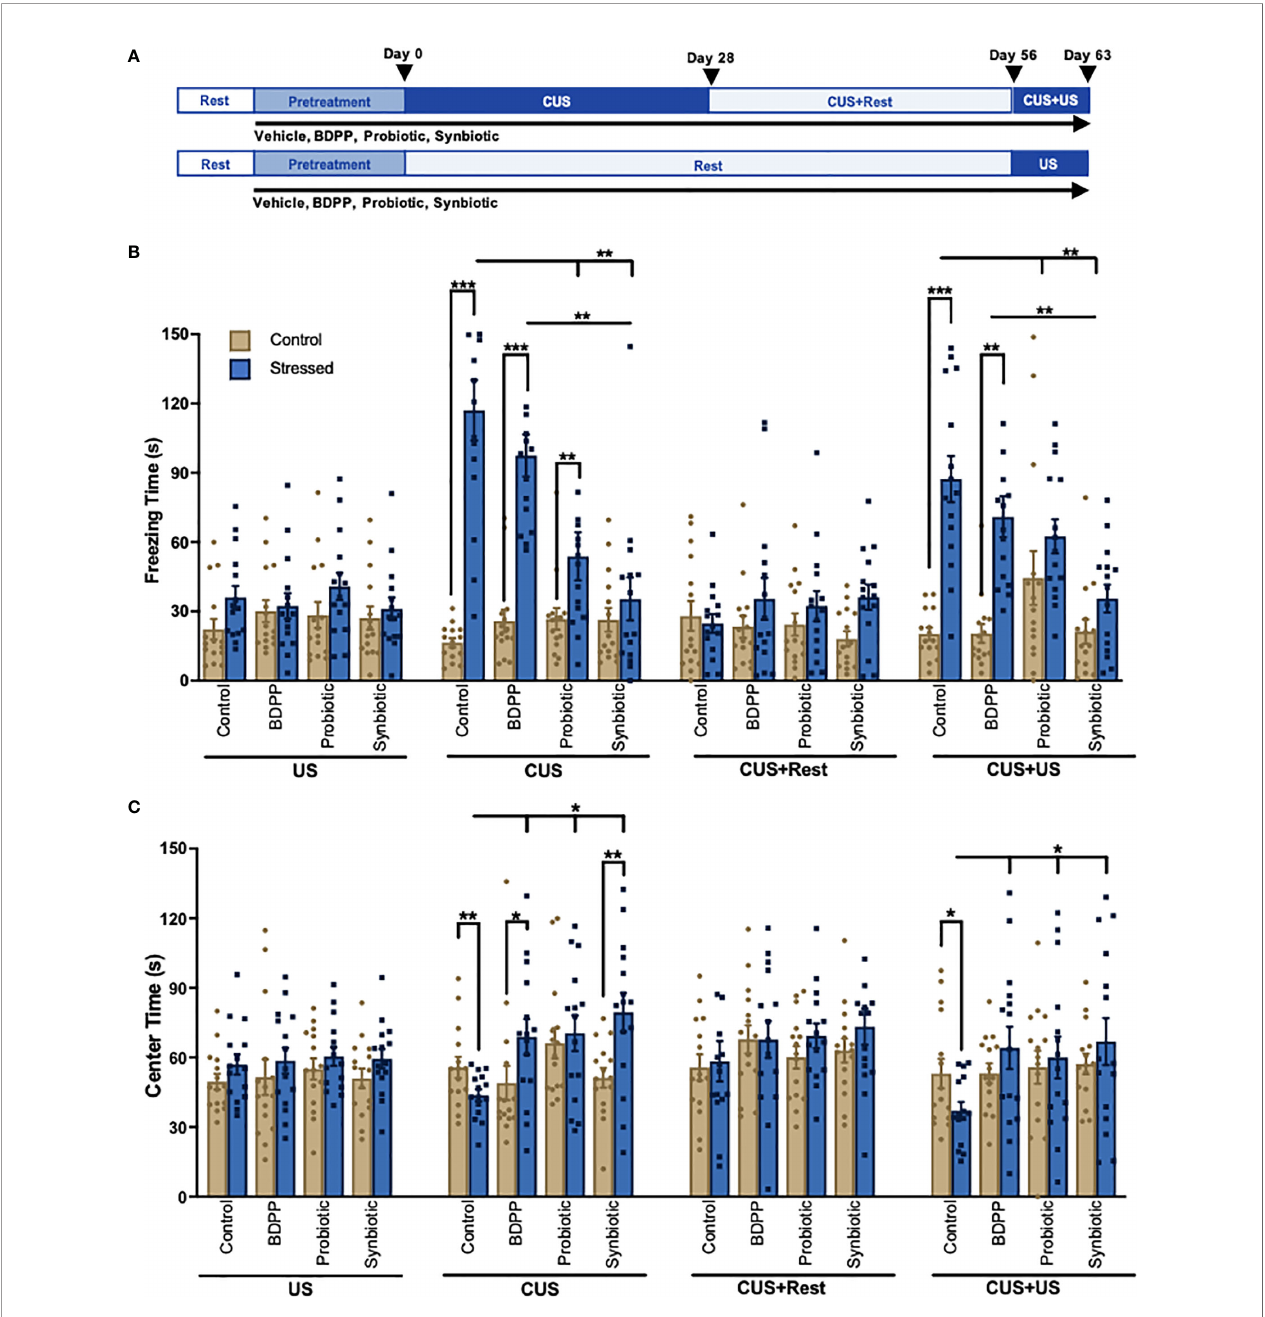
FIGURE 1 | A Synbiotic Attenuates Chronic-Stress Induced Psychological De fi cits. (A) Chronic and recurrent stress are modelled using the chronic unpredictable stress (CUS) protocol. Following 2 weeks of rest and 2 weeks of pretreatment with the BDPP, probiotics or synbiotics, mice are exposed to 28 days of random mild unpredictable stressors (CUS) following by 28 days of rest (CUS+Rest) and a re-stimulation of 7 days of unpredictable stress (US) modelling recurrent stress (CUS+US). The fi nal CUS+US timepoint can be compared to the 7-day subthreshold US. Each group contained n = 16 animals. Behavior phenotypes were assessed using the (B) forced swim test for depressive-like behavior and (C) open fi eld test for anxiety-like behavior where for each group there are n = 16 mice +/- SEM and signi fi cance is determined with a two-way ANOVA and Tukey ’ s post-hoc analysis. DC, dendritic cell; ILC, innate lymphoid cell; BC, B cell; Treg, regulatory T cell; Th17, T helper 17 cell; TNF b , tumor necrosis factor b ; TLR4, toll-like receptor 4; NF k B, nuclear factor kappa light chain enhancer of B cells; Casp1, caspase1; IL-1 b , interleukin 1 beta; CCL2(MCP1), monocyte chemoattractant protein 1; CCL5(RANTES), C-C motif 5; ICAM, intercellular adhesion molecule; VCAM, vascular cell adhesion molecule. In all cases, *p < 0.05, **p < 0.01, ***p <